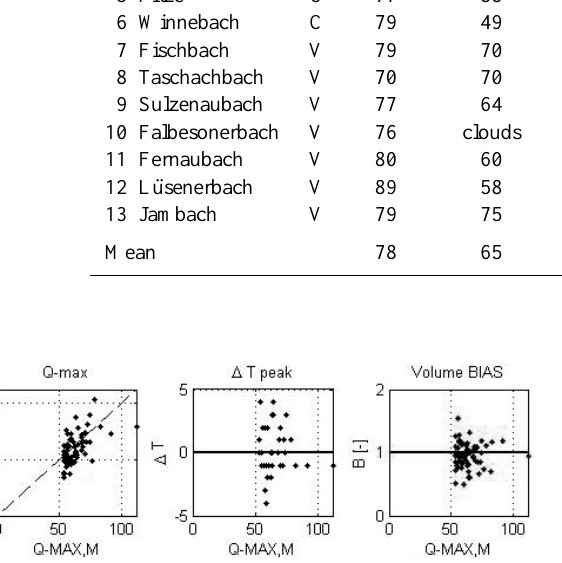
for Obergurgl. A mean overall agreement of 78% was